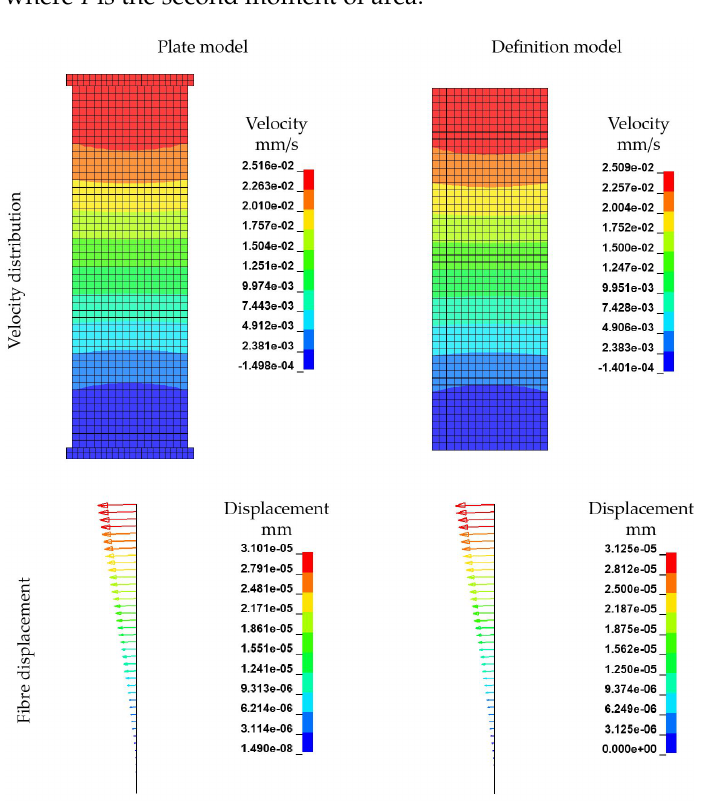
Figure 16. Influence of boundary condition for the velocity definition by plate (FSI) and direct definition.